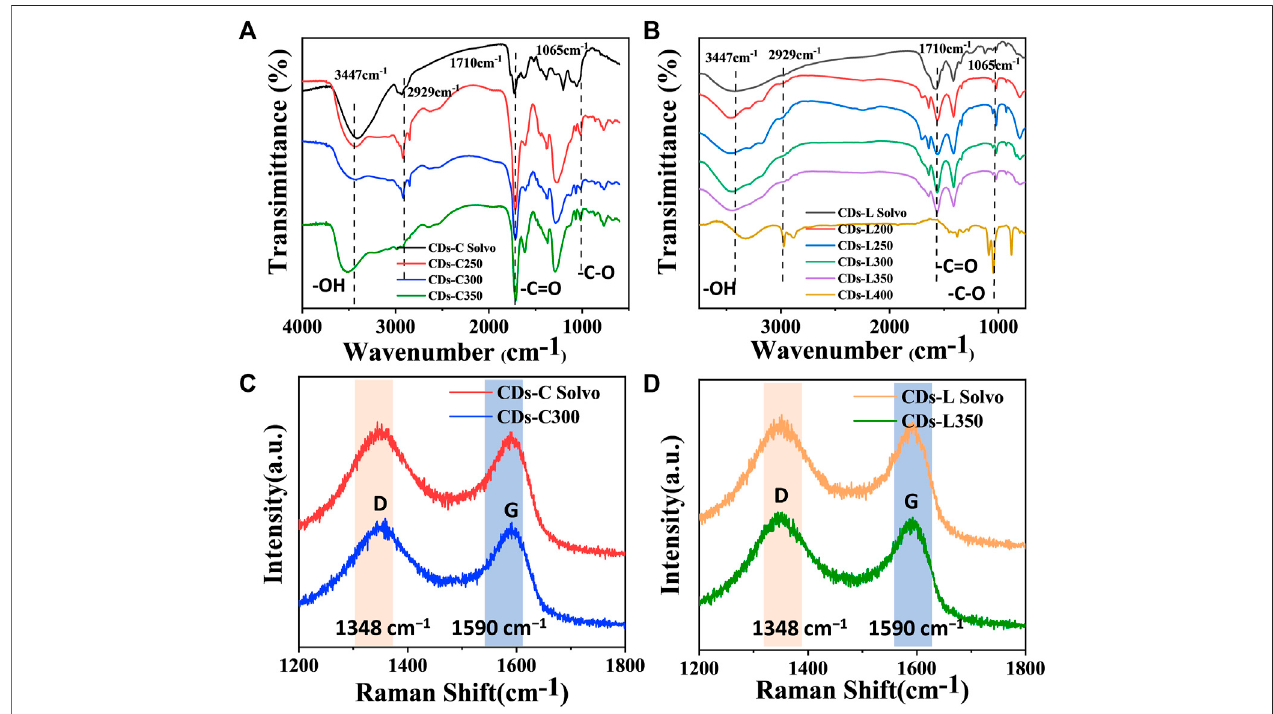
FIGURE 5 | (A,B) FT-IR spectra of CDs based on (A) cellulose and (B) lignin. (C,D) Raman spectra of CDs-C Solvo, CDs-C 250, CDs-L Solvo, and CDs-L 250.